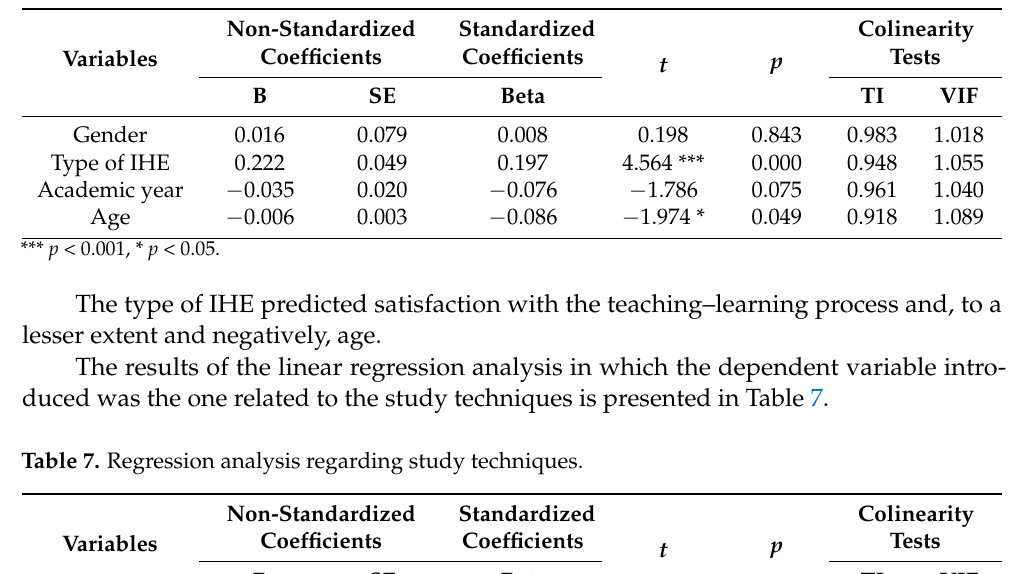
Table 6. Regression analysis regarding satisfaction with the teaching–learning process.